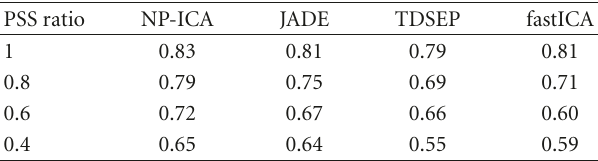
Table 1: Classification accuracy (percentage) obtained with the di ff erent variants of ICAMM.